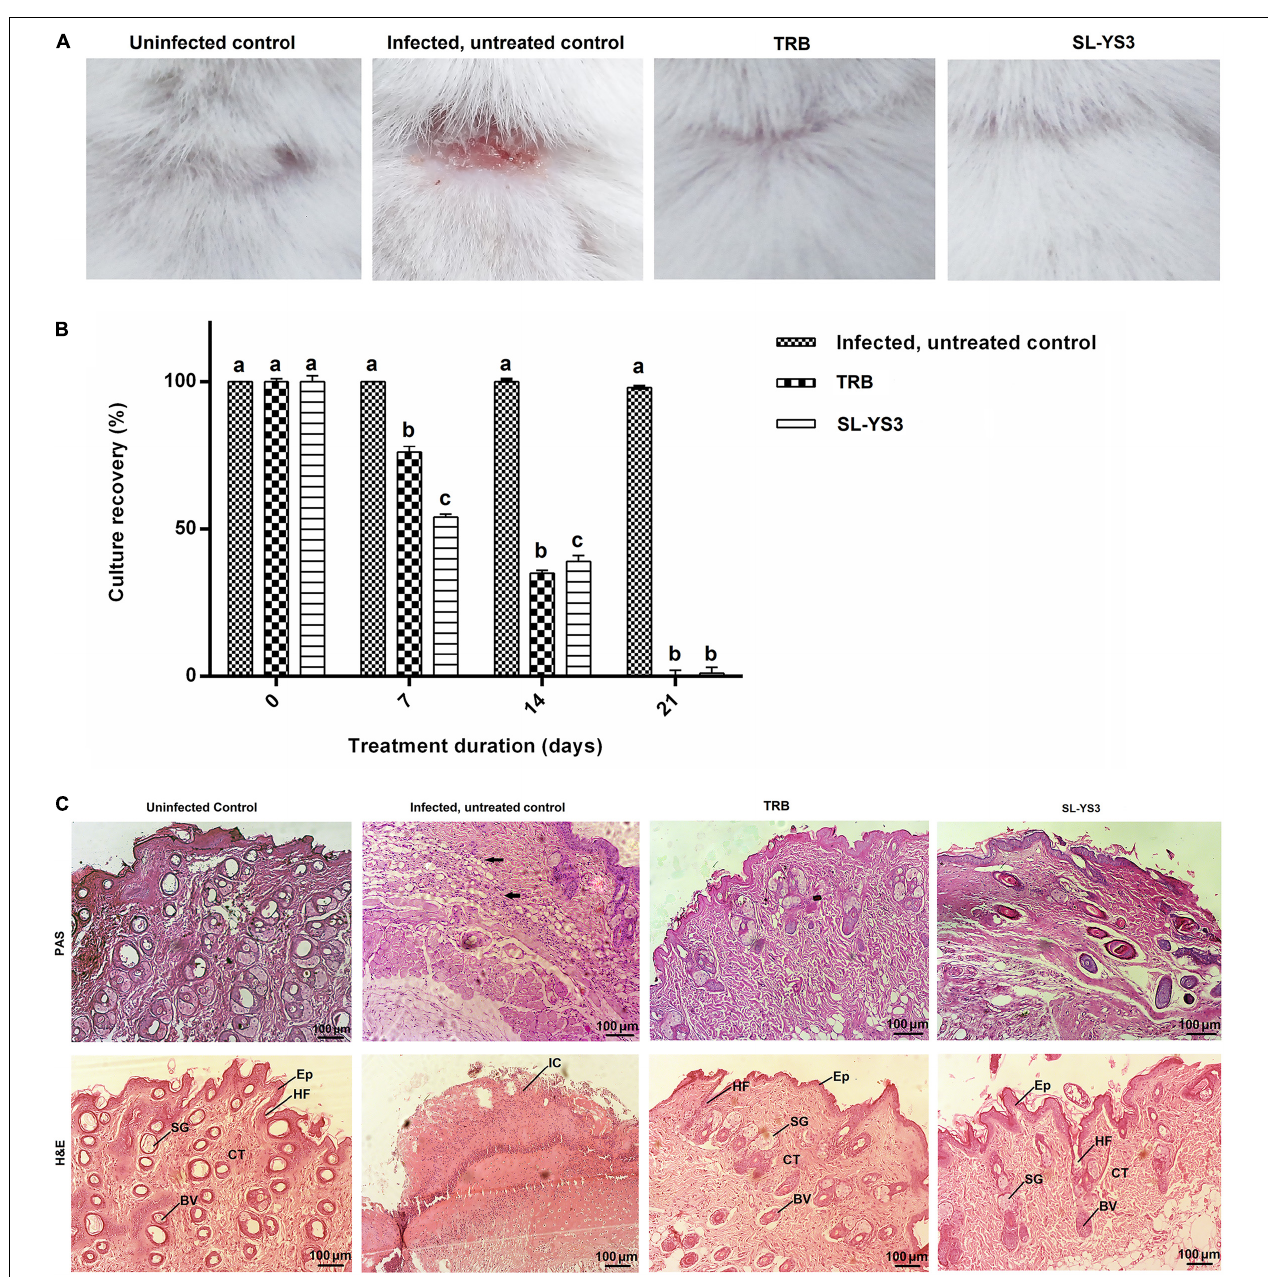
FIGURE 9 | Therapeutic efficacy of sophorolipid produced by R. babjevae YS3 (SL-YS3) on experimentally induced dermatophytosis in mice infected with T. mentagrophytes . (A) Macroscopic observation of the infected sites of the mice treated with 1 mg ml − 1 (w/v) SL-YS3 and terbinafine (TRB) at the end of 21 days of treatment in comparison to the uninfected and infected, untreated control. (B) Culture recovery (%) of T. mentagrophytes from skin samples collected at different intervals of treatment period (0, 7, 14, 21 days) and cultured to determine the therapeutic efficacy in eradication of the fungus. Error bars represent standard deviation. Different letters indicate significantly different values as per ANOVA-LSD. (C) Histopathology of skin samples collected from sophorolipid (SL-YS3) and terbinafine (TRB) treated groups, stained with hematoxylin & eosin (H&E) and Periodic acid- Schiff (PAS) stains. SG, sweat glands; Ep, epidermis; HF, hair follicle; BV, blood vessel; CT, collagenase tissue; IC, inflammatory cells. Magnification = 10 × , Scale bar = 100 µ